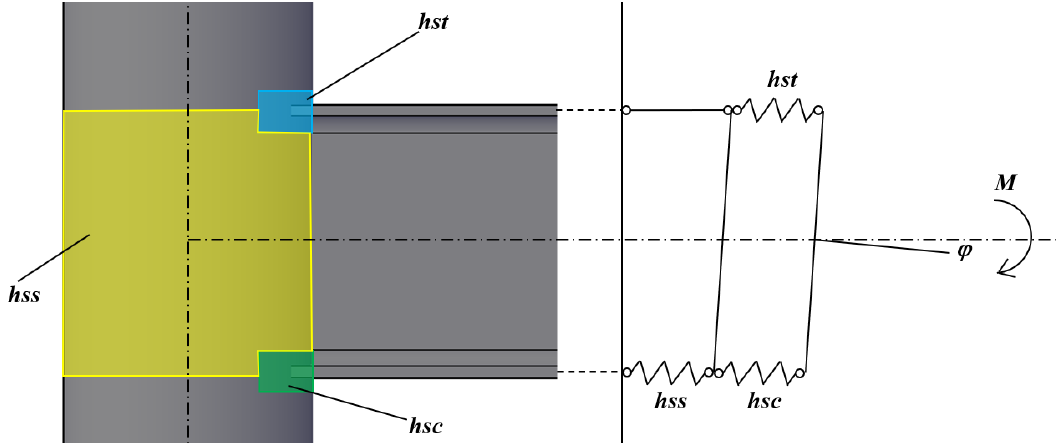
Figure 12. Main sources of deformability: hss (hollow section in shear), hsc (hollow section in transverse compression), hst (hollow section in transverse tension).